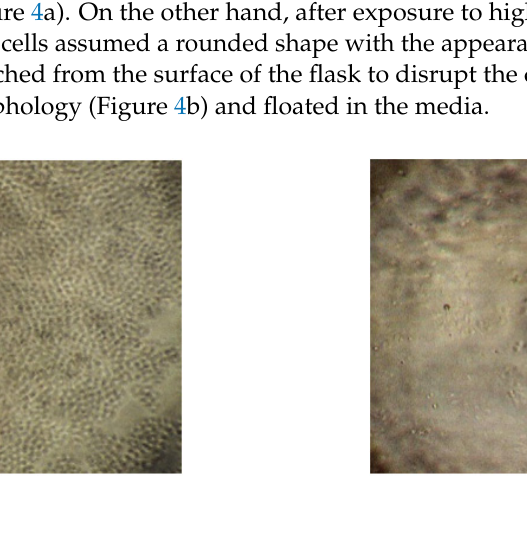
Figure 4. Cell morphology following exposure to polymer solution for 72 h. ( a ) Confluent adherent cells after exposure to HPMC (1 mg/mL) solution and ( b ) reduced cell viability after exposure to CP 971 (1 mg/mL) solution (40× magnification) .